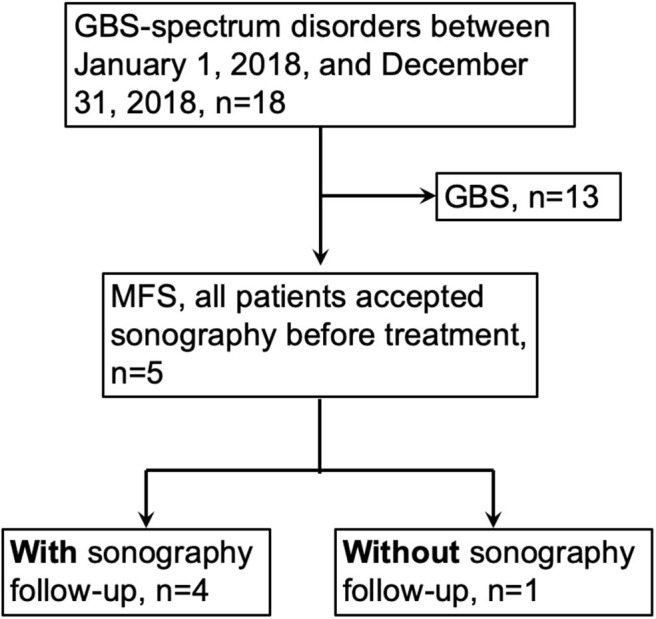
Patient recruitment algorithm. GBS, Guillain-Barre syndrome; MFS, Miller-Fisher syndrome.